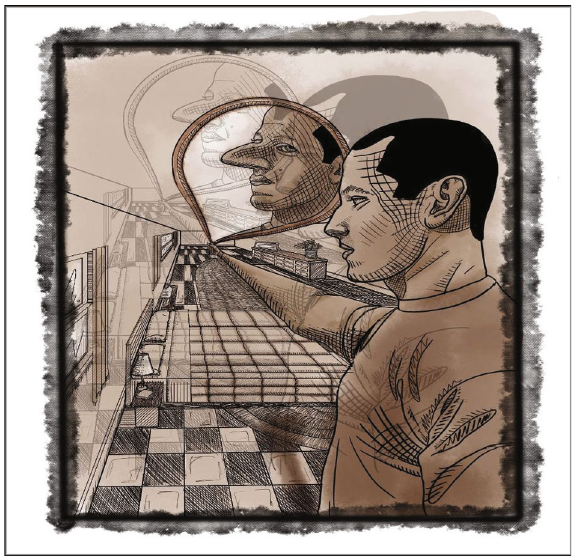
Figure 1: This image was painted by an artist during the patient ’ s inpatient hospitalization to illustrate the feelings that the patient